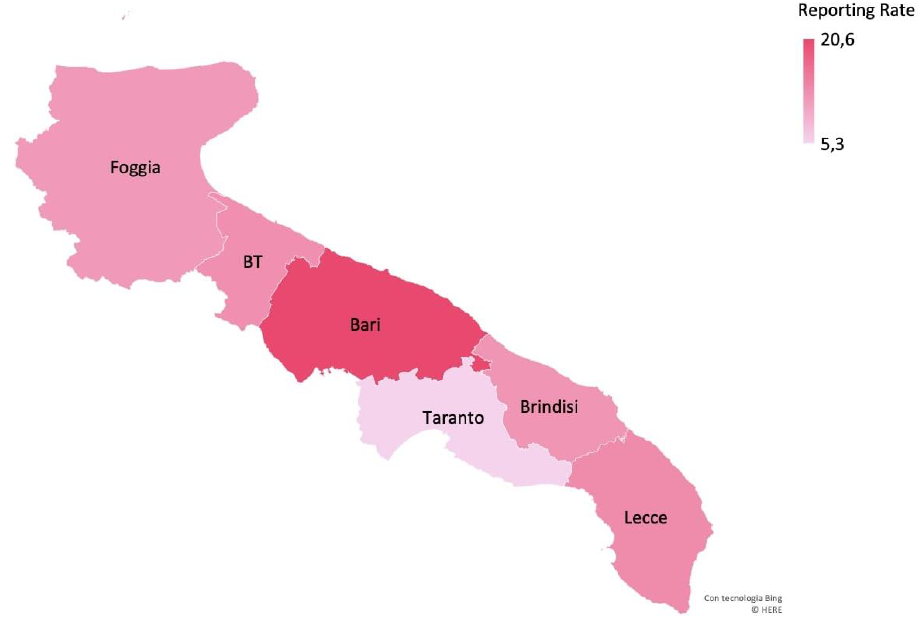
Figure 2. Mean annual reporting rate (per 100,000 children <15 years old) of cases of STEC infection by province, Apulia region.